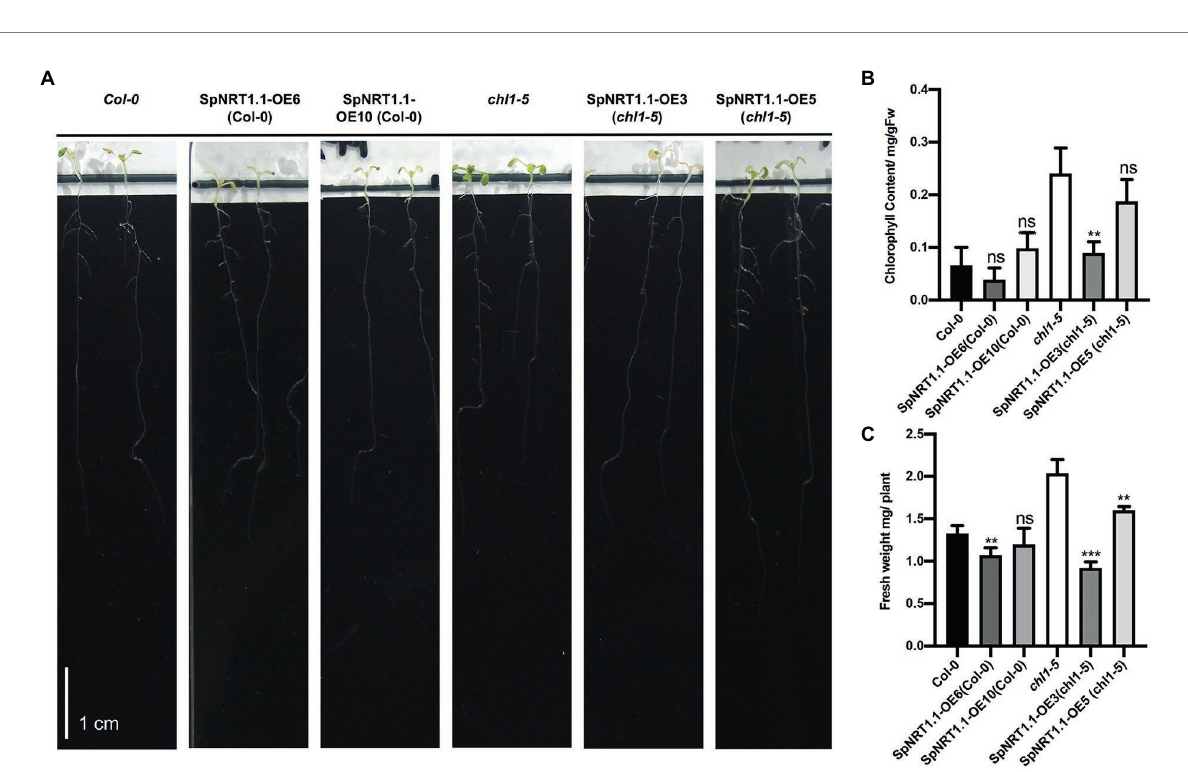
FIGURE 4 Overexpression of SpNRT1.1 in Col-0 and chl1-5 in Arabidopsis leads to etiolated phenotype under chlorate-supplied conditions. (A) Phenotype of SpNRT1.1 overexpressed lines and complemented lines under chlorate-supplied conditions. (B) Chlorophyll content of Col-0 and transgenic lines compared with chl1-5 plant. (C) Shoot fresh weight of Col-0 and transgenic lines compared with chl1-5 plant. Student’s t -test was used for significant difference analysis. Asterisks indicate significance levels compared with chl1-5 mutant plants, n ≥ 3, ** p < 0.01, *** p < 0.001. Scale bar = 1